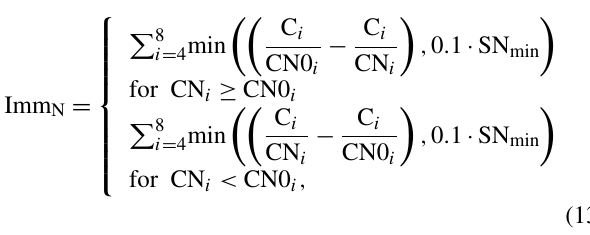
Based on the comparison Based on the available soil Based on foliage N